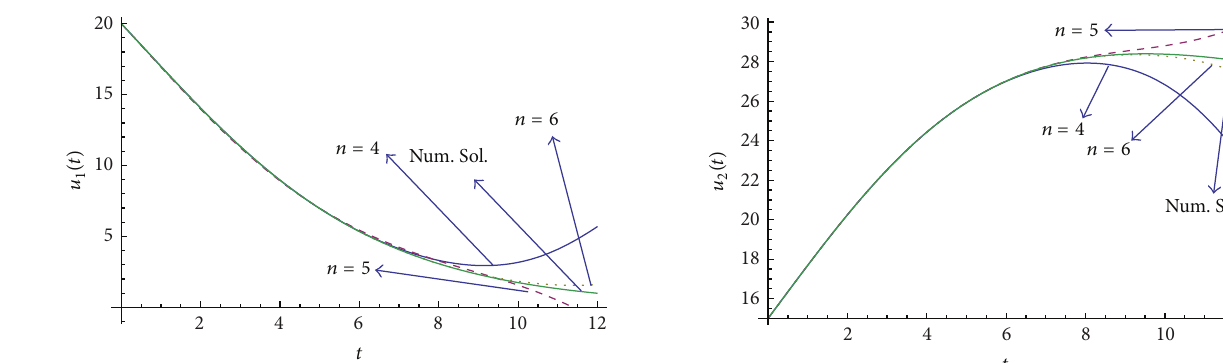
Figure 2: Comparison of iterations ( 𝑛 = 4, 5, 6 ) of PIA(1, 1) and numerical solutions for 𝑢 2 .